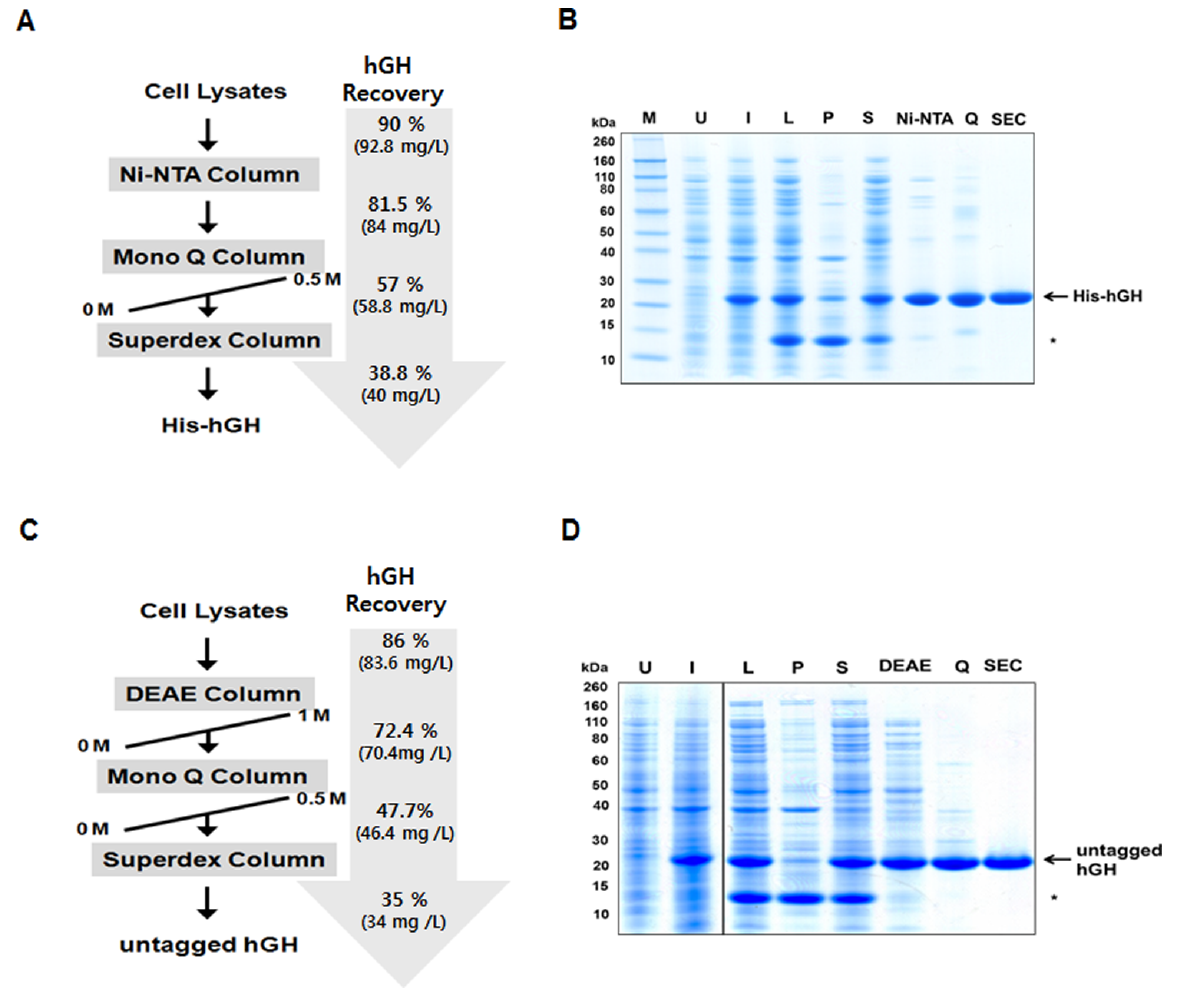
Figure 3. Purification of recombinant hGH under optimized conditions. (A) Scheme of His-hGH purification from E. coli . The arrow indicates the overall yield of hGH at each step in the purification process. (B) Purification of His-hGH. Elutions from each column were separated on a 4–12% SDS-polyacrylamide gel and analyzed by Coomassie blue staining. (C) Scheme of His-hGH purification from E. coli . (D) Purification of untagged hGH. Elutions were analyzed as in (B).